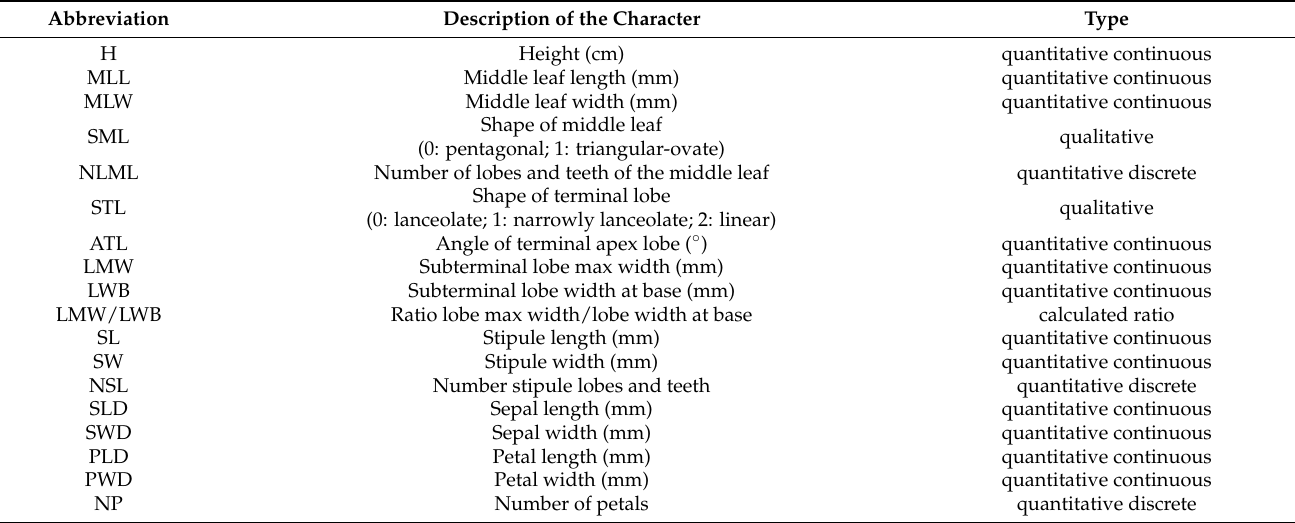
Table 1. Morphological characters